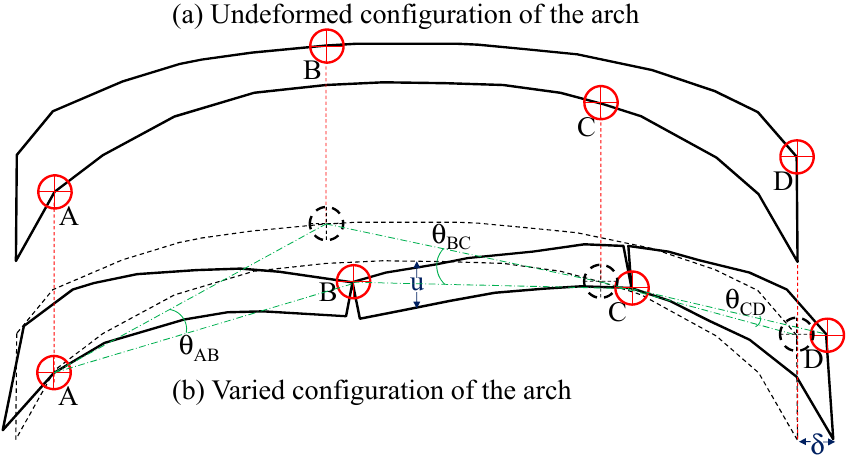
Figure 4. Varied geometrical configuration of the arch due to the horizontal settlement δ imposed at the right constraint.